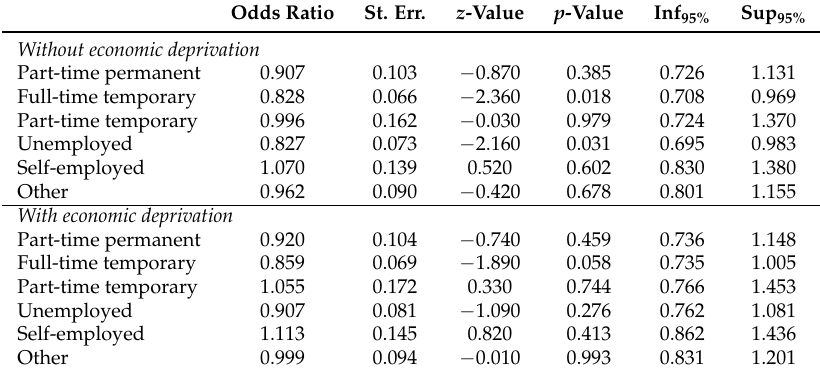
Table 10. Correlated random-effects ordered logit model: estimated odds ratios for employment status (ref.: Full-time permanent)—Southern countries. Odds Ratio St. Err. z -Value p -Value Inf 95% Sup 95% Without economic deprivation Part-time permanent